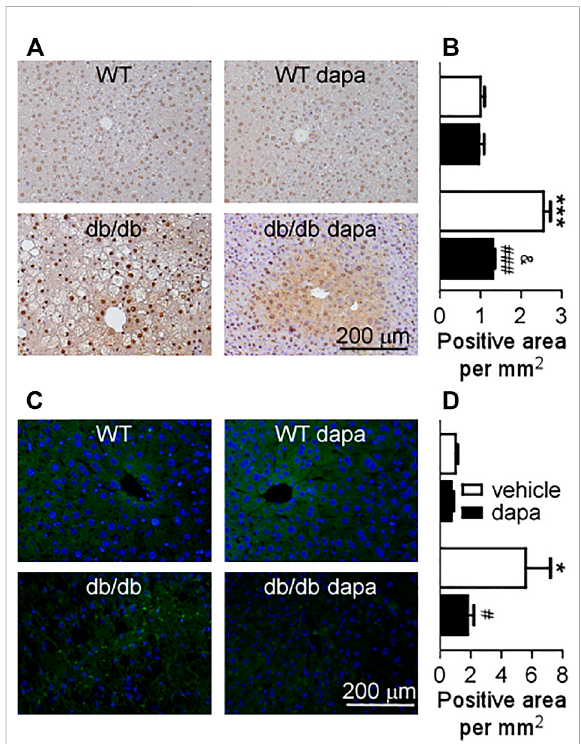
FIGURE 5 Dapagli fl ozin inhibited the expression of p-NF- κ B p65 and in fi ltration of immune cells (F4/80 + ) in the liver of db/db mice. (A) Immunohistochemistry of p-NF- κ B p65 in livers. (B) The relative level of integrated optical densities (IODs) of p-NF- κ B p65 in livers. (C) In fi ltration of immune cells (F4/80 + ) assessed by immunohistochemistry in the liver. (D) The relative level of the number of F4/80 + cells per mm 2 in the liver. Values were means ± SEM, n = 3. * p < 0.05, ** p < 0.01, and *** p < 0.001 vs. wild-type (WT) mice. # p < 0.05, ## p < 0.01, and ### p < 0.001 vs. db/db mice. & p < 0.05 vs. dapagli fl ozin-treated wild-type mice. One-way ANOVA, Bonferroni ’ s multiple comparison test. p-NF- κ B p65 = p-nuclear factor kappa B p65.